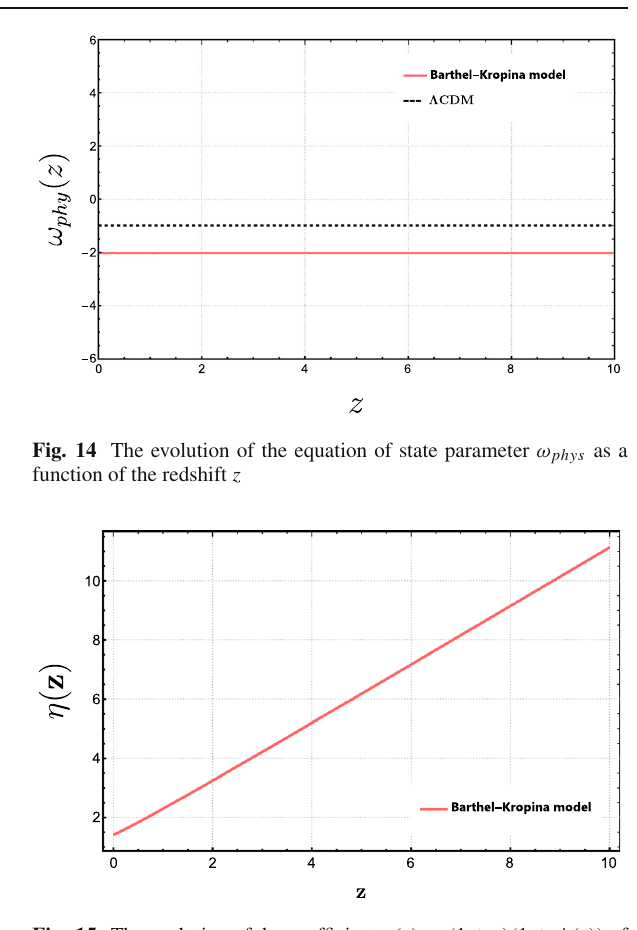
Fig. 15 The evolution of the coefficient η( z ) = ( 1 + z )( 1 + ψ( z )) of the one form β of the Kropina